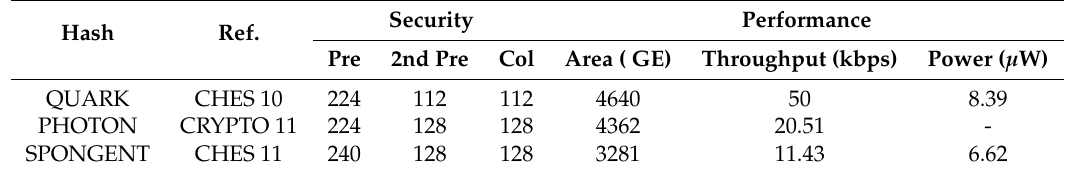
Table 5. Comparison security and performance of lightweight hash algorithms [34] (output size: 256 bit; GE < 5000; frequency: 100 kHz).